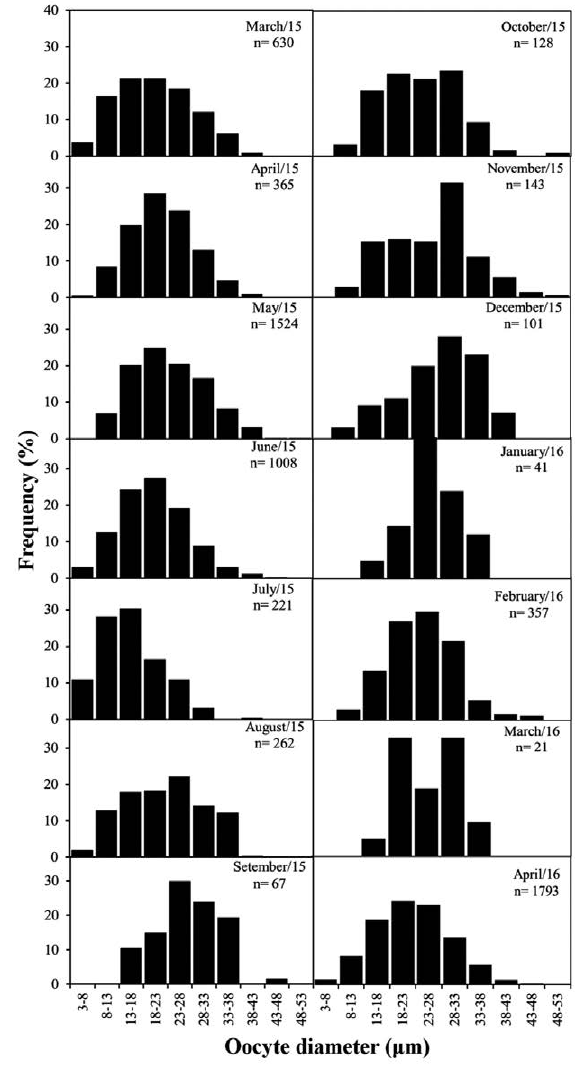
Fig. 6. – Monthly distribution of the absolute frequency of oocyte diameters in Donax striatus .